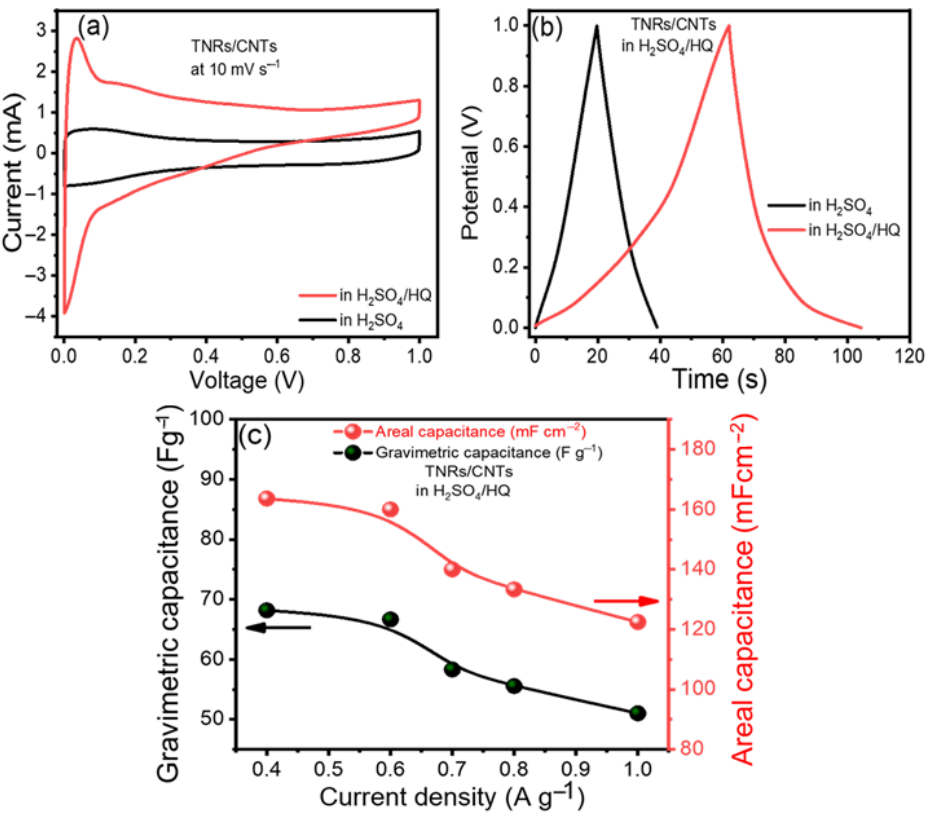
Figure 4. Electrochemical performance improvement: ( a ) cyclic voltammograms (CVs) and ( b ) charge/discharge curves (CDs) of TNR/CNTs in H 2 SO 4 and a mixed electrolyte, respectively, and ( c ) gravimetric and areal capacitances of the TNR/CNTs in the mixed electrolyte at different current densities.